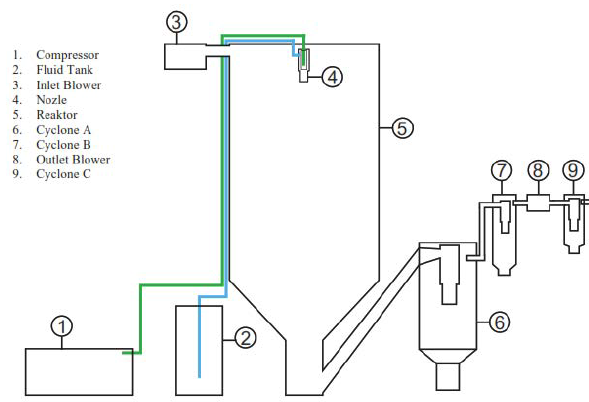
Figure 1: Schema of Spray Dryer Machine